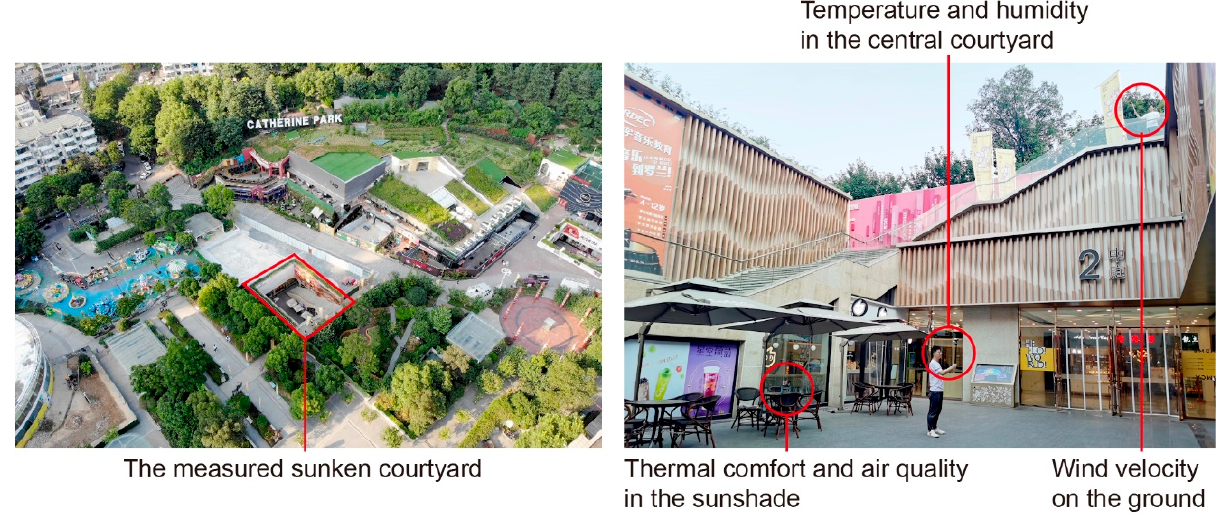
Figure 1. The measured sunken courtyard in Nanjing, China.